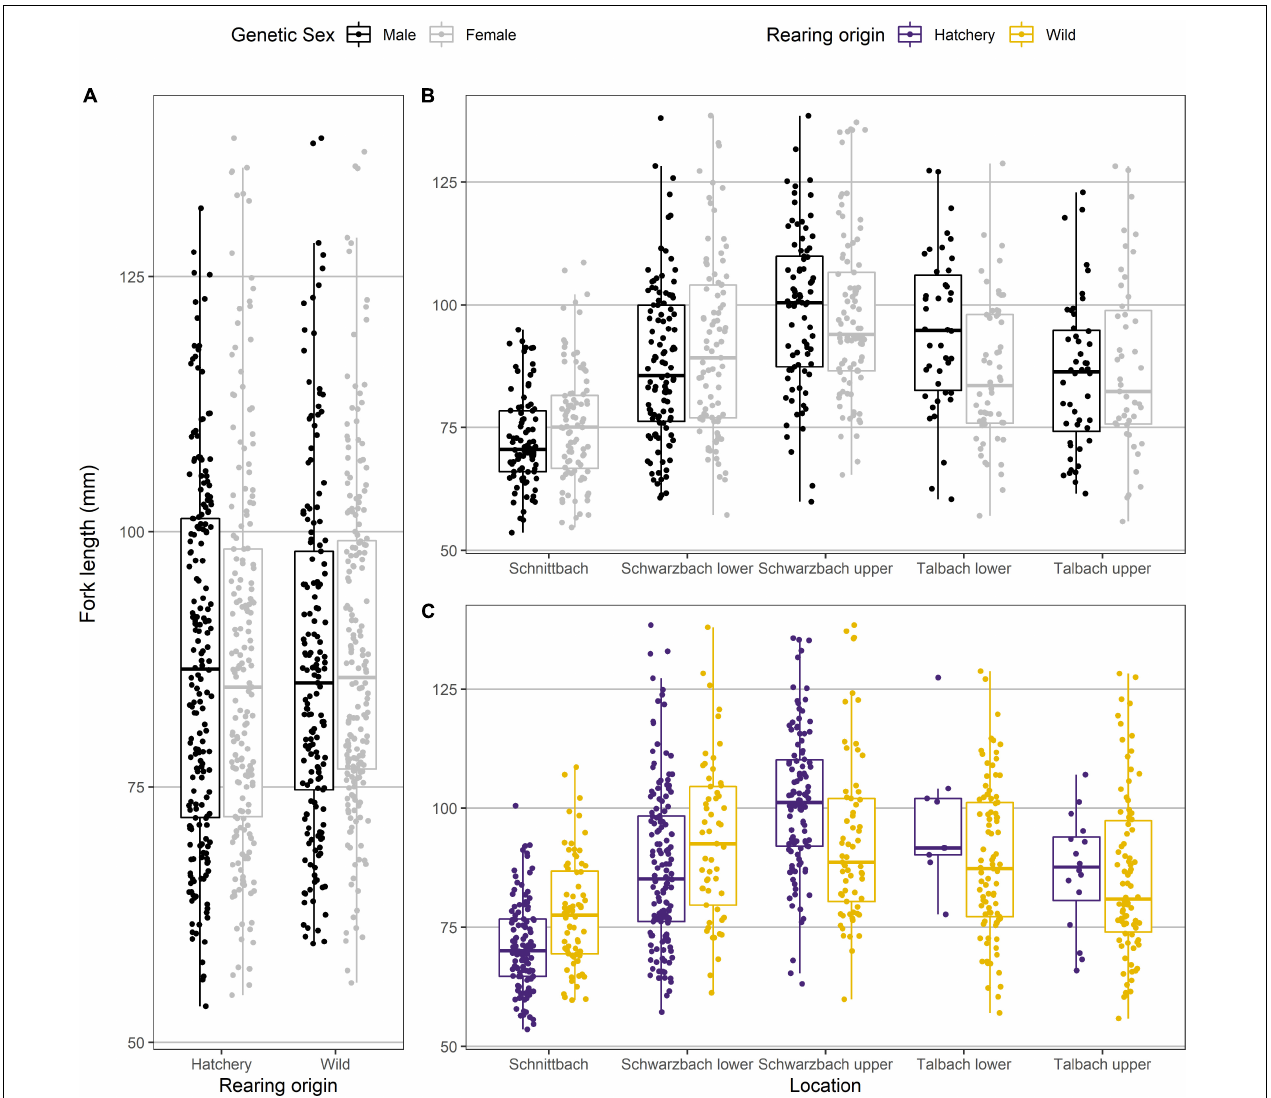
FIGURE 3 | Boxplots showing the effects of the interactions between (A) genetic sex and rearing origin, (B) genetic sex and location, and (C) rearing origin and location on length in fish in the field experiment. See Table 2B for